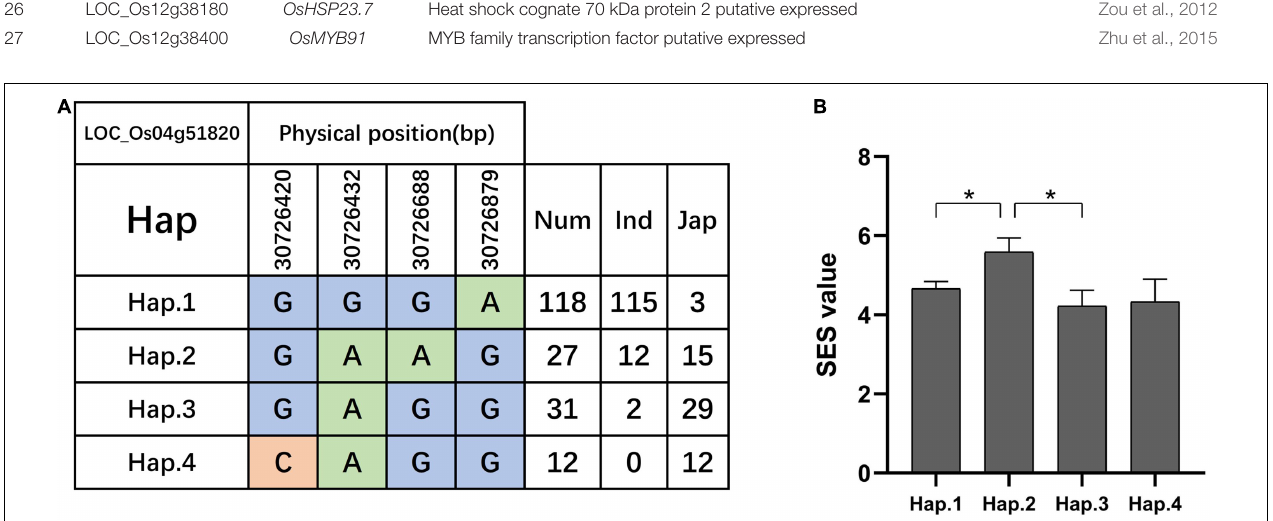
FIGURE 4 | Haplotype analyses of OsHKT1;1 ( LOC_Os04g51820 ). Gene structure (A) and SES (B) of different haplotypes of OsHKT1;1. T-test, * P < 0.05.